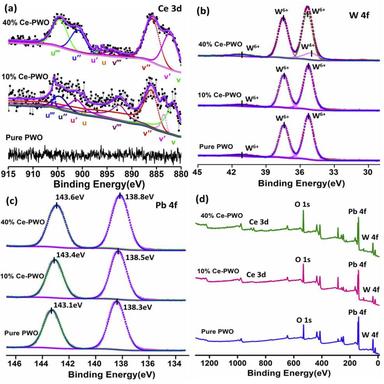
High-resolution of Ce 3d (a), W 4f (b), Pb 4f (c) and XPS spectra of Ce-PWO (d).